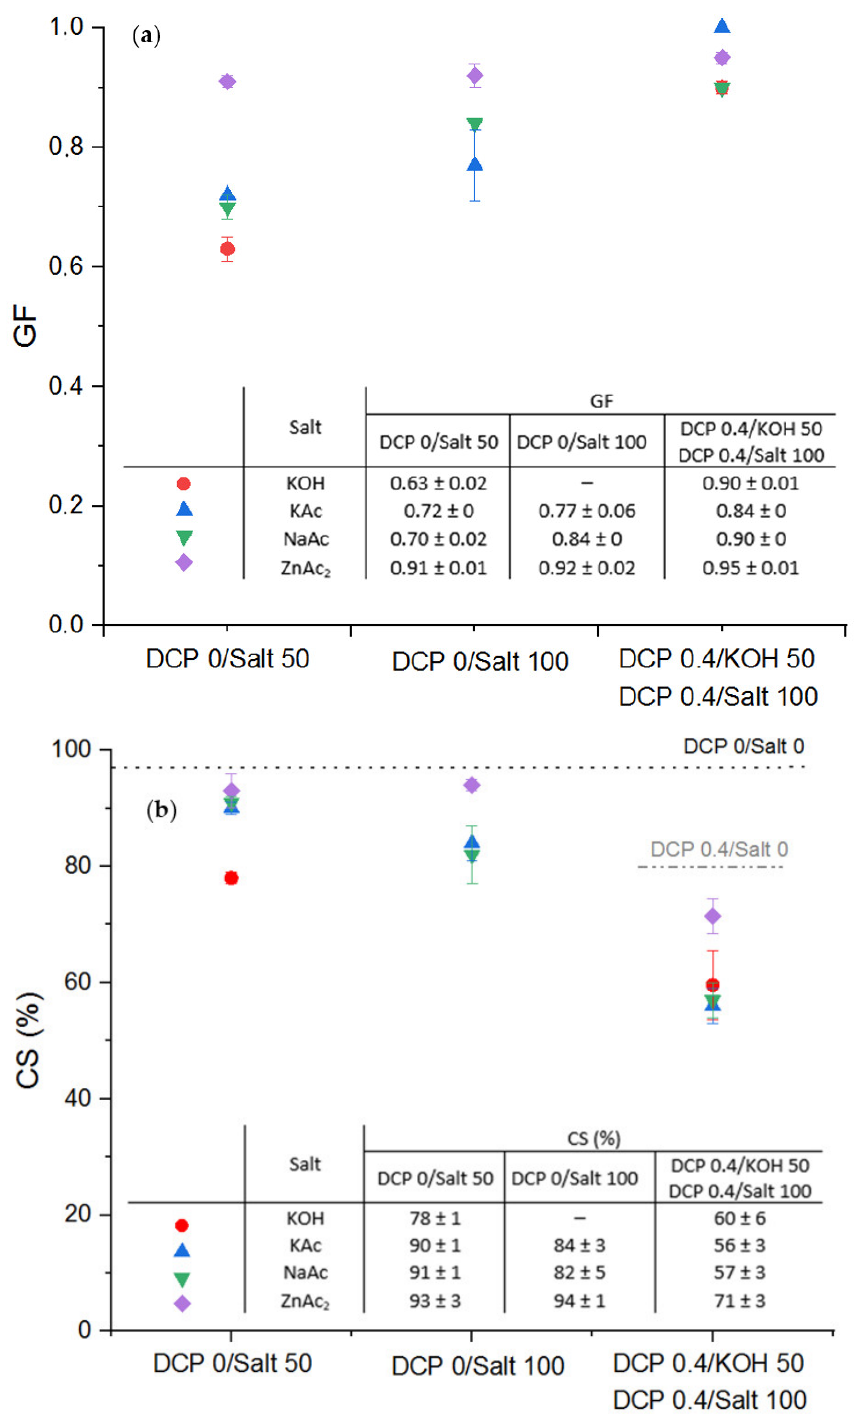
Figure 9. Variation of the gel fraction ( a ) and the compression set ( b ) of EPDM-g-MA crosslinked with different ions (KOH, KAc, NaAc, and ZnAc 2 ) and with the combination of both ionic and covalent networks.